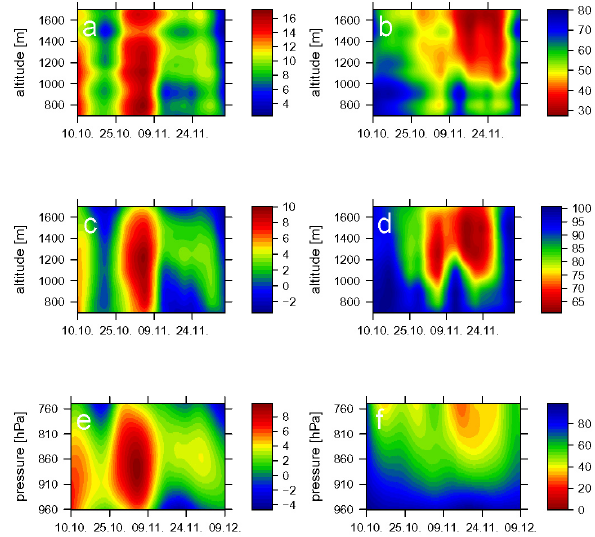
Fig. 4. Meteorological conditions ( a daily maximum temperature, b daily minimum relative humidity, c daily minimum temperature, d daily maximum relative humidity) at the south-facing slope where Felsenkanzel station is located. Data from within-stand tempera- ture and relative humidity data loggers. (e) and (f) temperature and relative humidity measured by the daily atmospheric soundings at Innsbruck